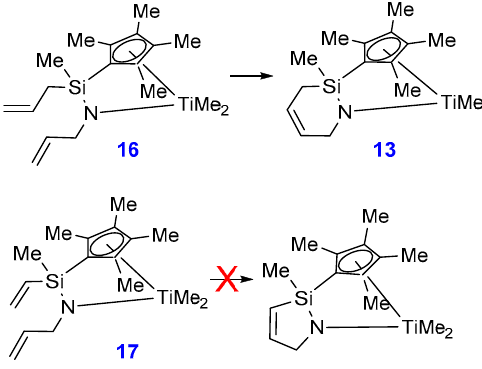
Scheme 2. Ring closure metathesis (RCM) of the titanium complexes.